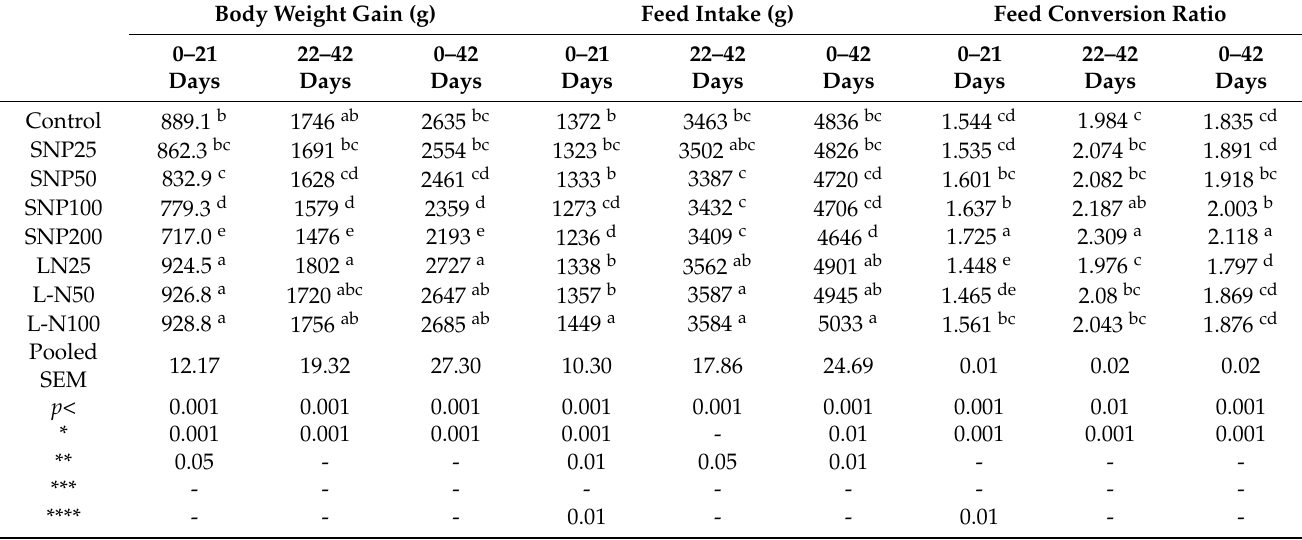
Table 2. Effect of dietary sodium nitroprusside (SNP) and N G -nitro-L-arginine methyl ester (L-NAME) supplementation on body weight gain, feed intake, and feed conversion ratio on days 0–21, 22–42, and 0–42